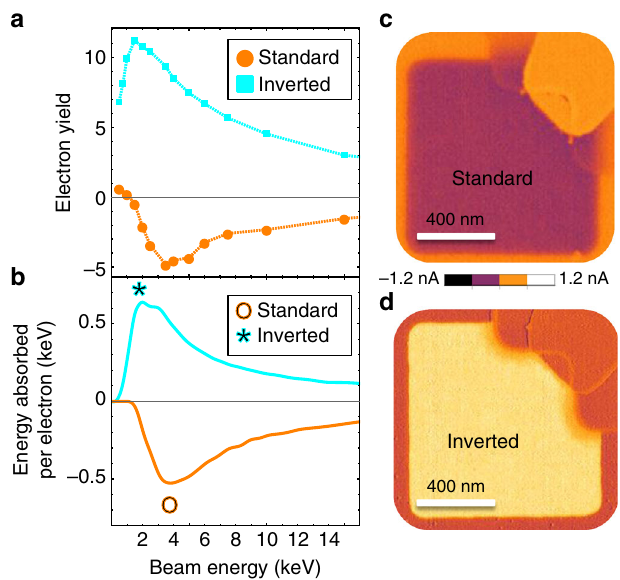
Fig. 4 Pristine device measurements. a Measured energy dependence of the electron beam-induced current (EBIC) signal for the virgin device in standard and inverted devices. The measured current is negative in the standard device and positive in inverted device. The change in sign when fl ipping the device over is due to reversal of the built-in fi eld. Error bars, re fl ecting two standard deviations of the mean, are smaller than the markers and are determined from an area of at least 50 × 50 pixel bounding box on each pad. b Monte Carlo simulation results of inverted and standard structure absorbed energy per electron. Standard structure simulation result is shown with negative sign since absorbed energy is not a negative quantity and current direction is determined by structure. c 5 keV EBIC image of a standard device. d 2 keV EBIC image of an inverted device. The strong similarity between the measured and simulated curves show the strong relationship between absorbed energy and generated EBIC